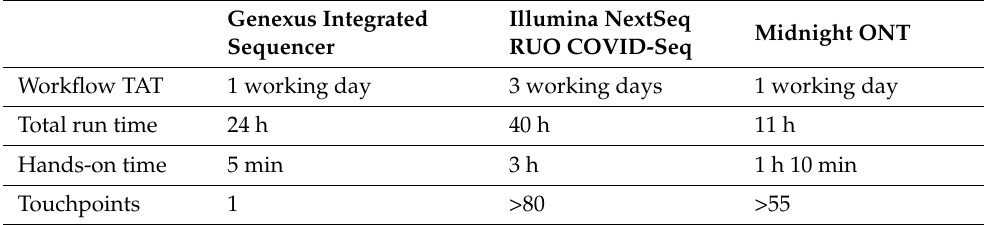
Table 1. Comparison of different SARS-CoV-2 sequencing